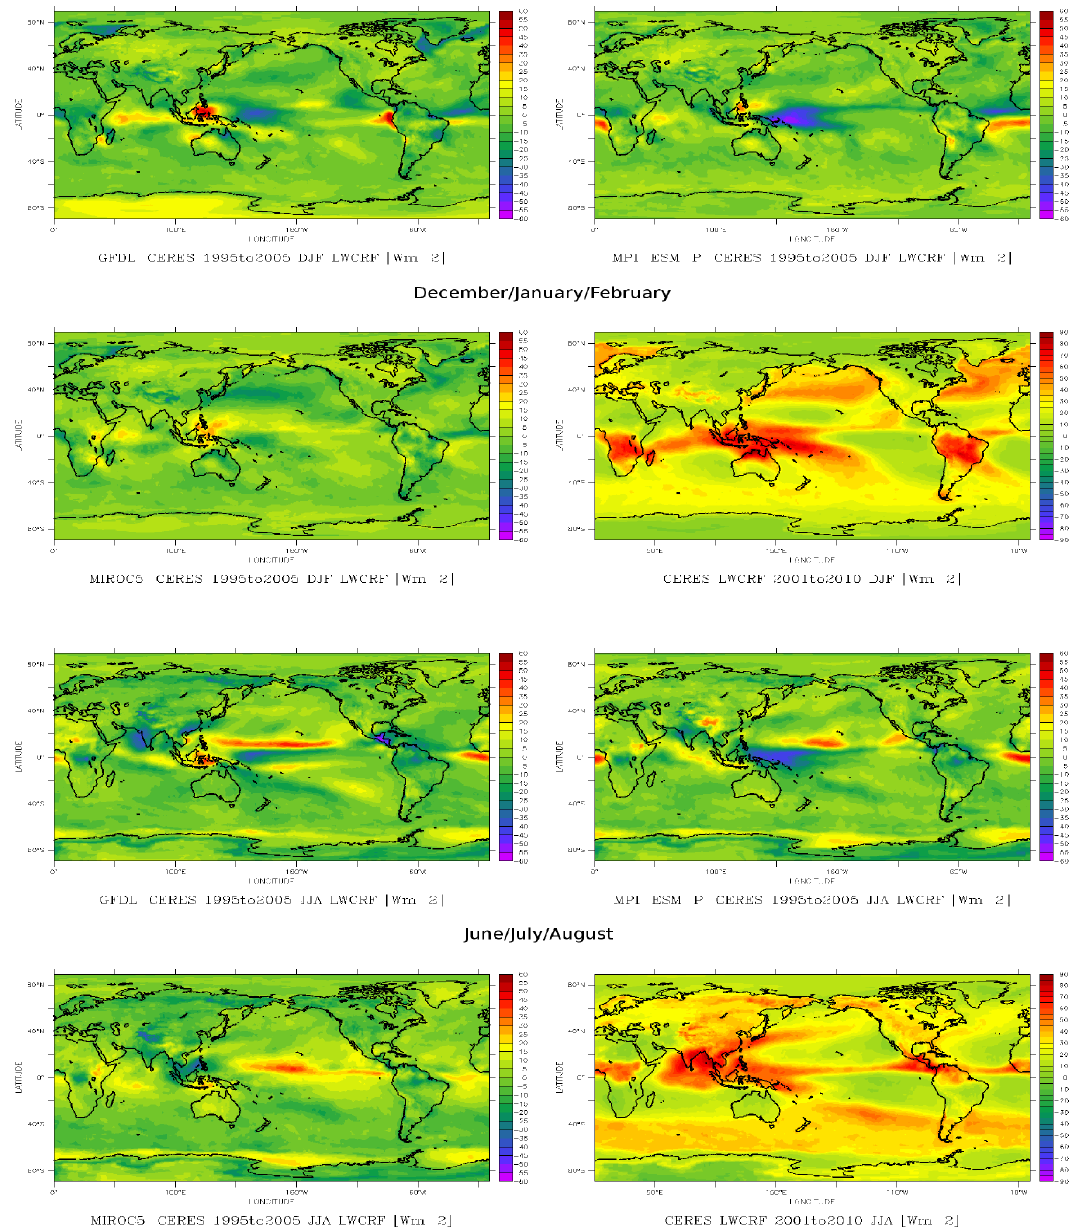
Figure 5. Seasonal plots showing the difference between CMIP5 and CERES for LWCRF for 10 years for MPI-ESM-P, MIROC5, and GFDL, as well as LWCRF observed by CERES. The upper four panels show DJF, lower four panels JJA. Plots show results given in Wm − 2